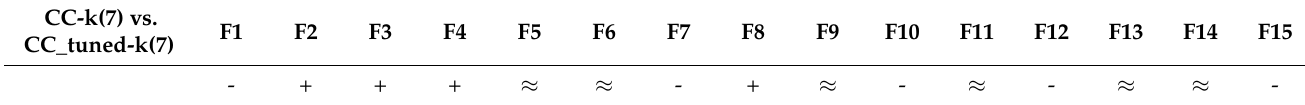
Table 8. The Wilcox rank-sum test CC-k(7) vs.